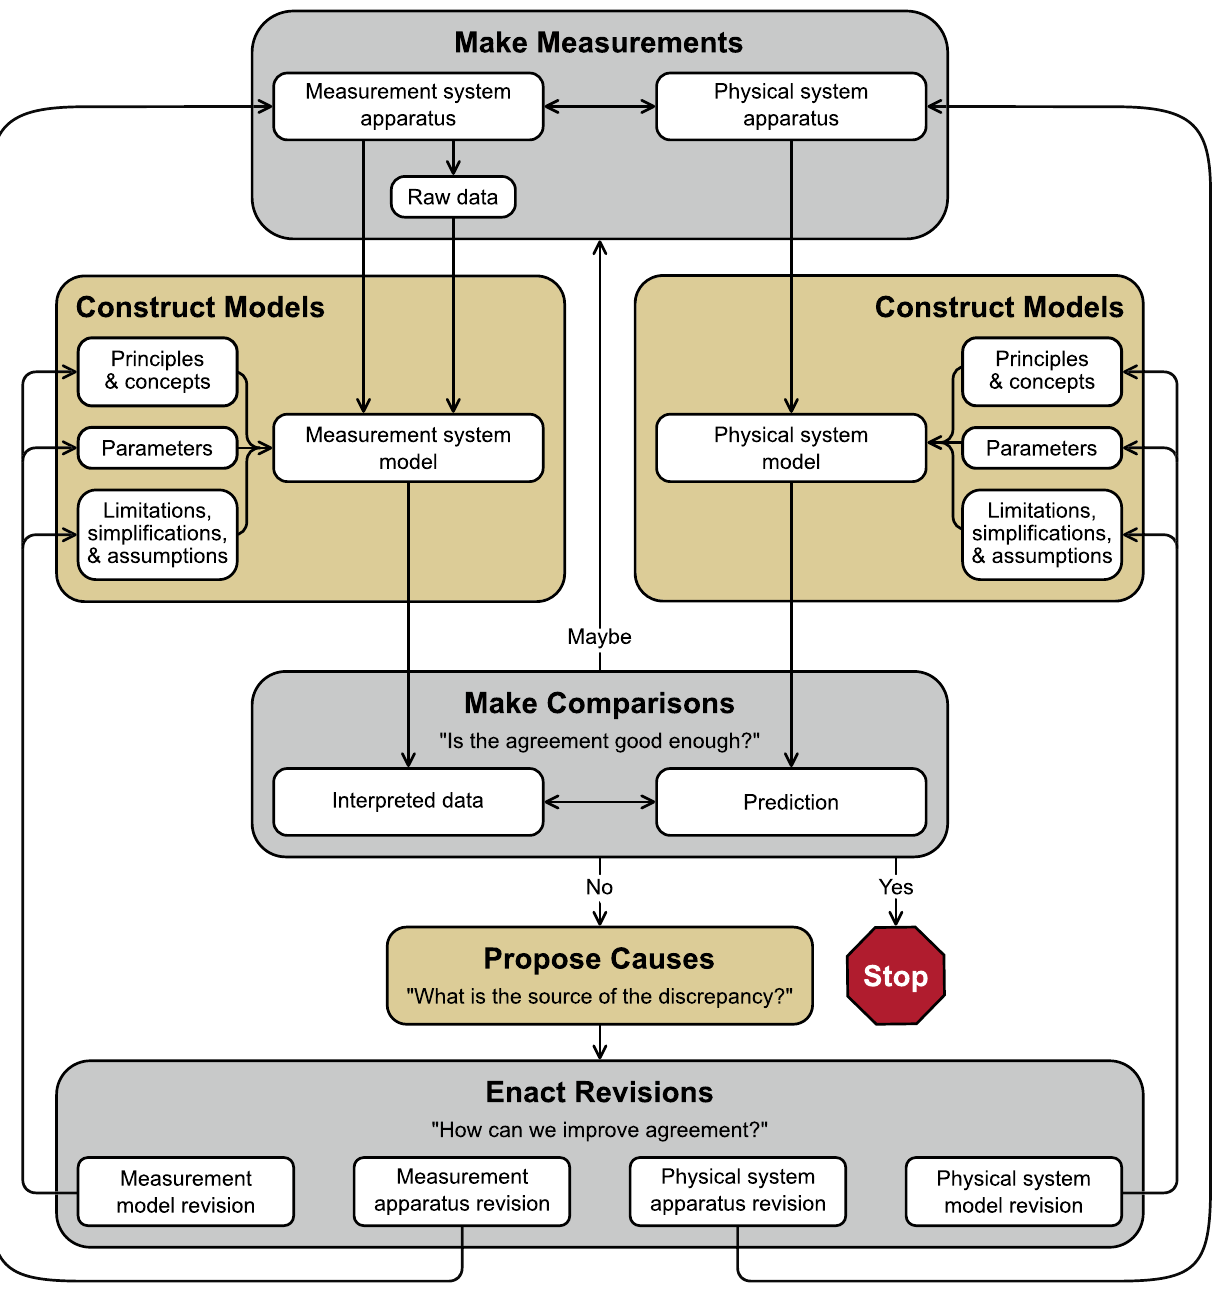
FIG. 1. The Experimental Modeling Framework, first published in Ref. [45] as a refinement of the original framework in Ref. [20]. The framework consists of five subtasks — make measurements, construct models, make comparisons, propose causes, and enact revisions — that are arranged in a flow chart that offers many possible paths through the process of